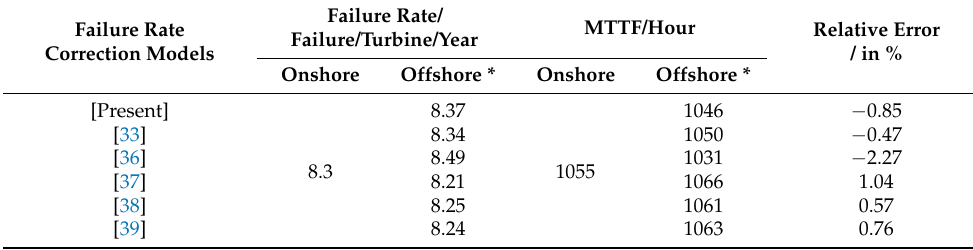
Table 14. Assessed failure features of the floating offshore wind